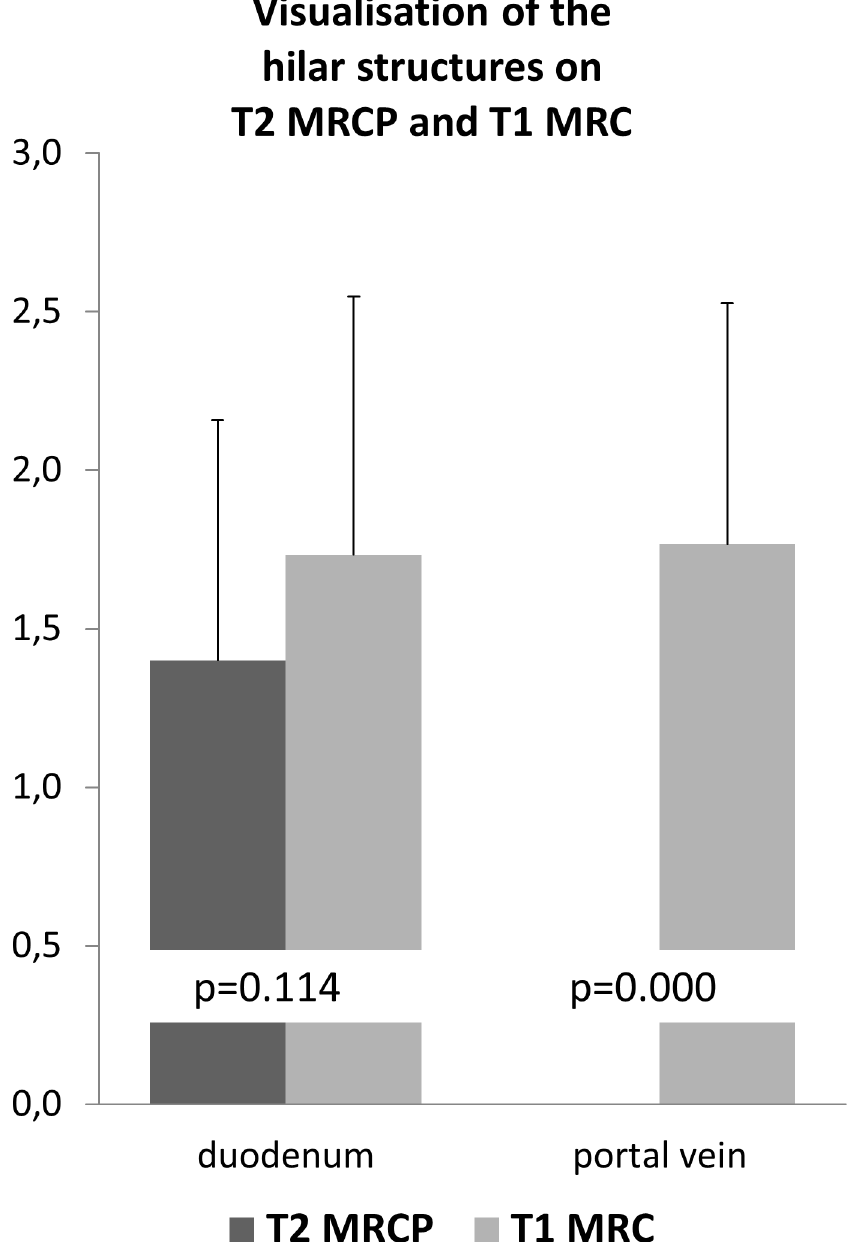
Fig 5. Visualisation of the hilar structures on T2 MRCP and T1 3D MRC. Depiction of the duodenum and thereby relationship of the biliary structures is better with T1 3D MRC. Additionally, the portal vein is confidentially depicted which is not visualised at all on T2